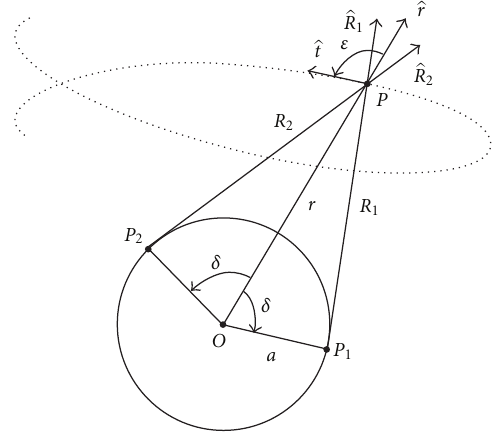
Figure 15: Geometry of the problem in the plane (cid:6) t , (cid:6) r .